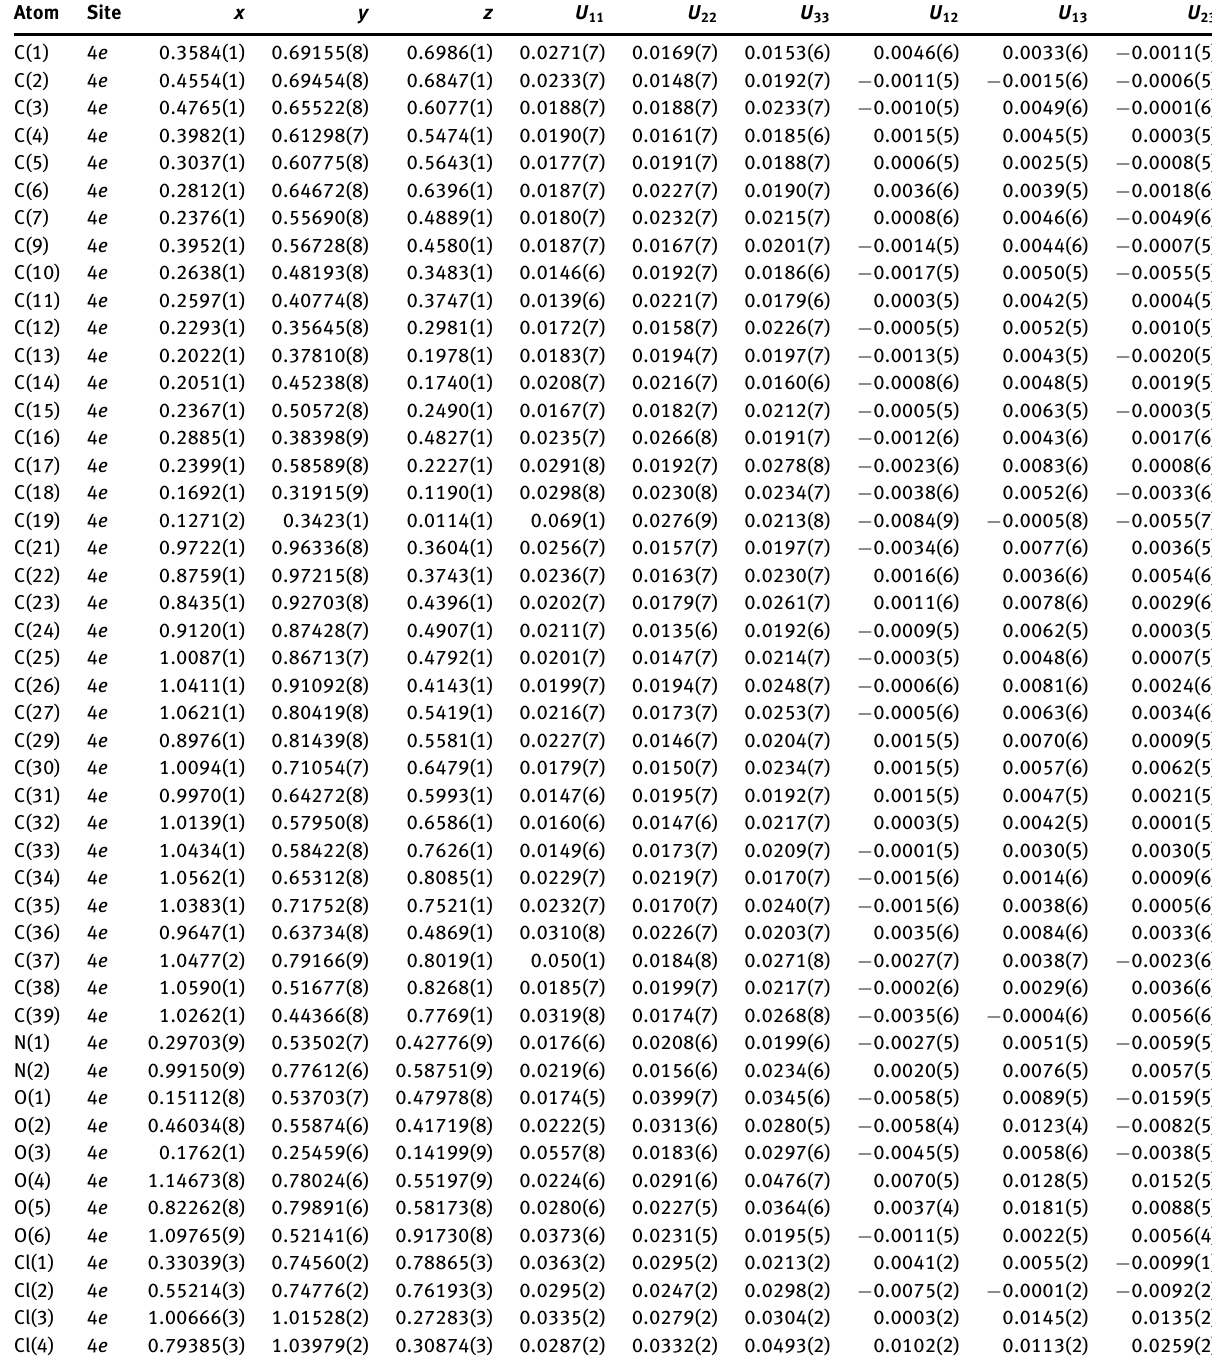
Table 3: Atomic displacement parameters (Å 2